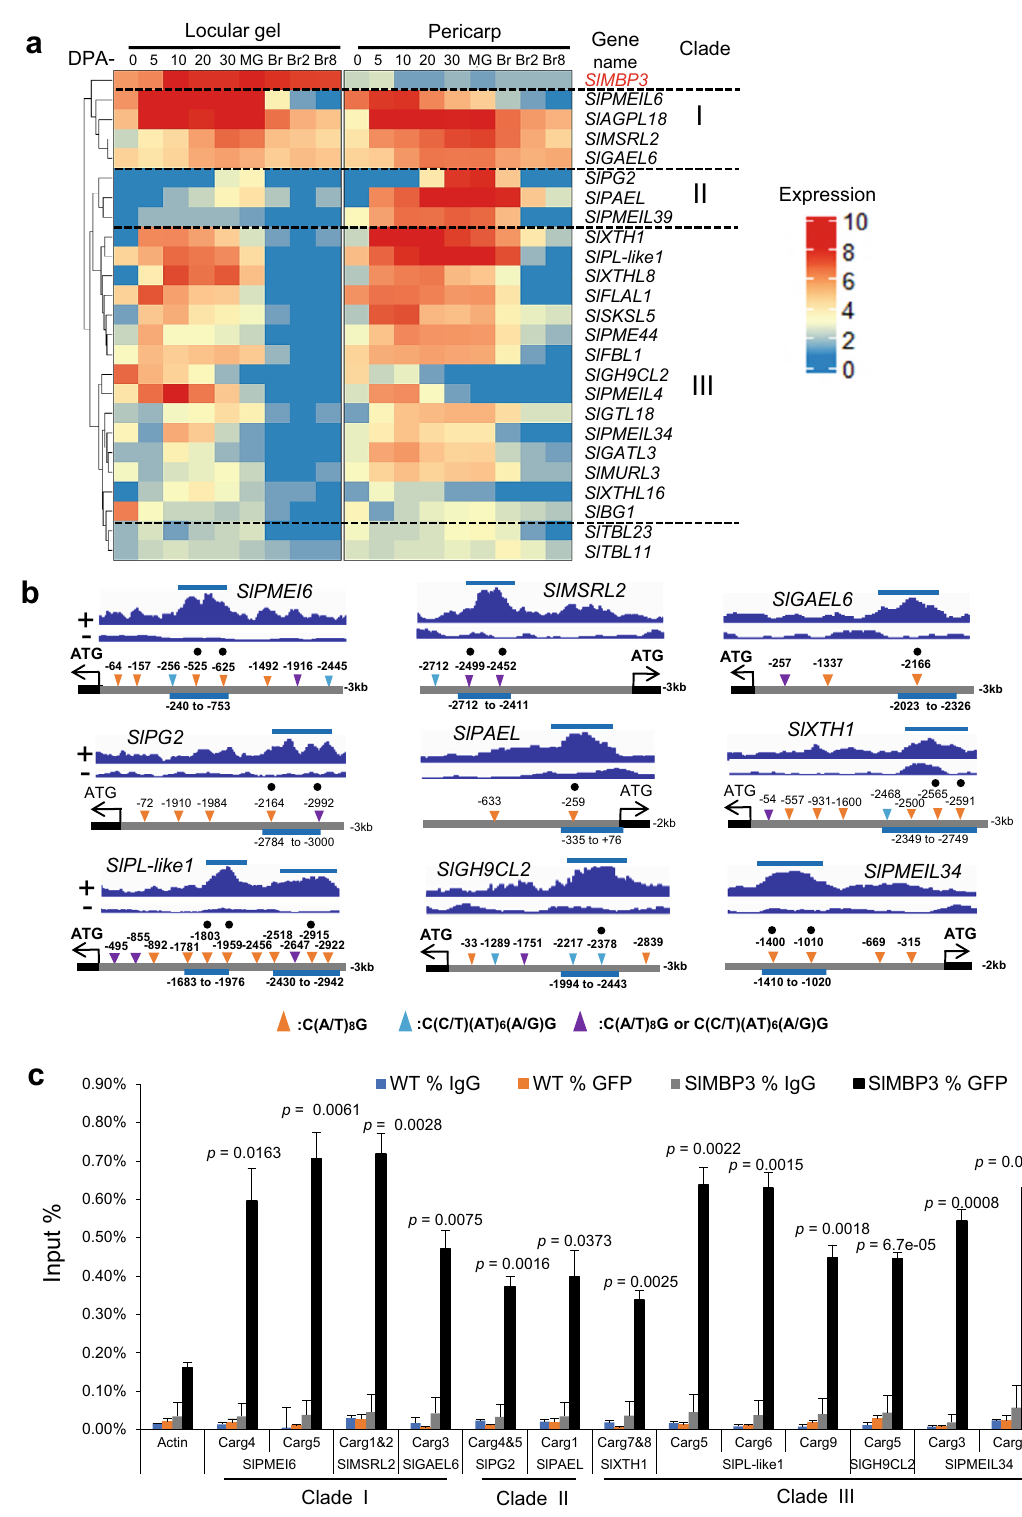
Fig. 6 Expression pattern of cell wall-related genes differentially expressed in SlMBP3 -KO lines being putative targets of SlMBP3 . a Heatmap representation of the expression patterns of 24 cell wall genes de fi ned as direct SlMBP3 targets by ChIP-seq and as differentially expressed in locular tissue of CRISPR/Cas9-KO lines. DPA, days post-anthesis; MG, mature green; BR, breaker. b DNA enrichment revealed by ChIP-seq experiment and visualized with Integrative Genomics Viewer (up panel) for nine cell wall genes (top panel). + and – correspond to enriched and input samples. For each gene, the localization of three types of CArG-box motifs within a 3-kb promoter region of nine cell wall genes (lower panel) is indicated by triangles. Light blue bars indicate the length of enriched peak. Black circles indicate the position of CArG boxes selected for validation by qPCR based on their high enrichment pro fi le. c ChIP-qPCR of nine cell wall genes selected as putative direct targets of SlMBP3 . Values are means ± standard deviation (SD) of three biological replicates. Signi fi cance was determined by two-tailed Student ’ s t -test. Source data are provided as a Source Data fi